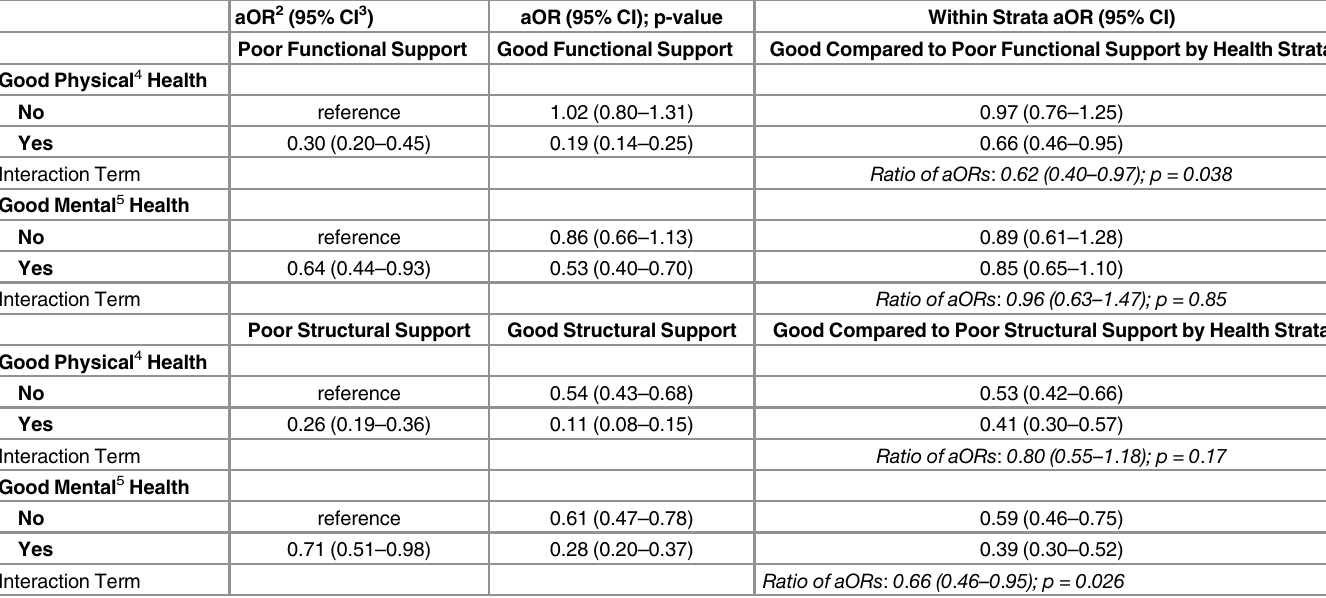
Table 6. Evaluation of the Differential Effect of Support at Different Levels of Health 1